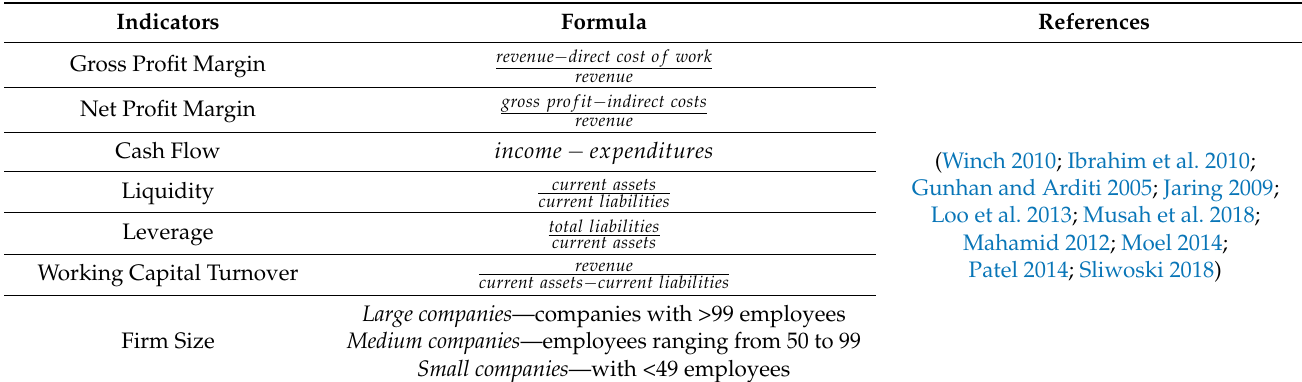
Table 1. Indicators for assessing financial performance of construction